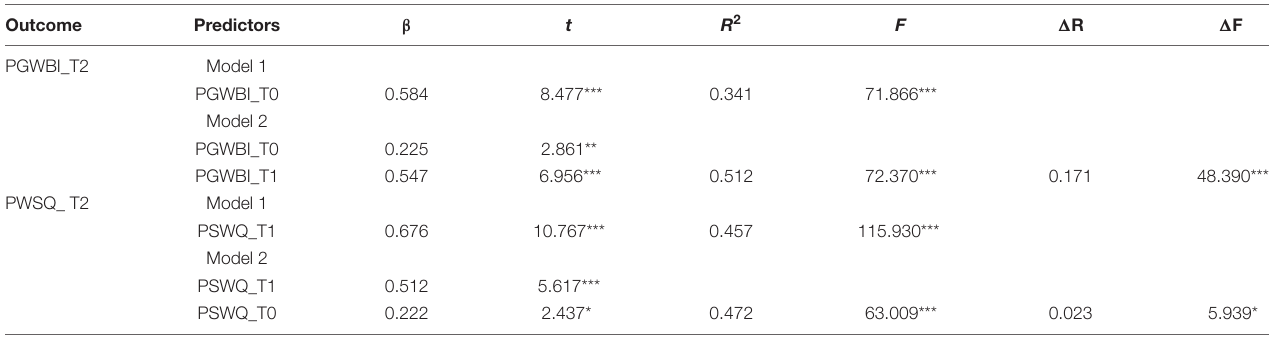
TABLE 3 | Stepwise regression analysis on worry and psychological well-being during